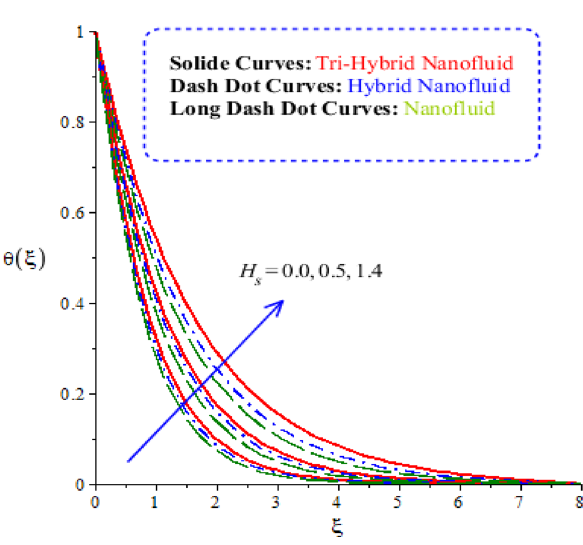
Figure 11. Comparative variation of temperature curves among nanoparticles versus H s